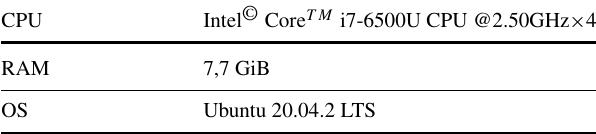
Table 11 Technical specifications of the computer used for the